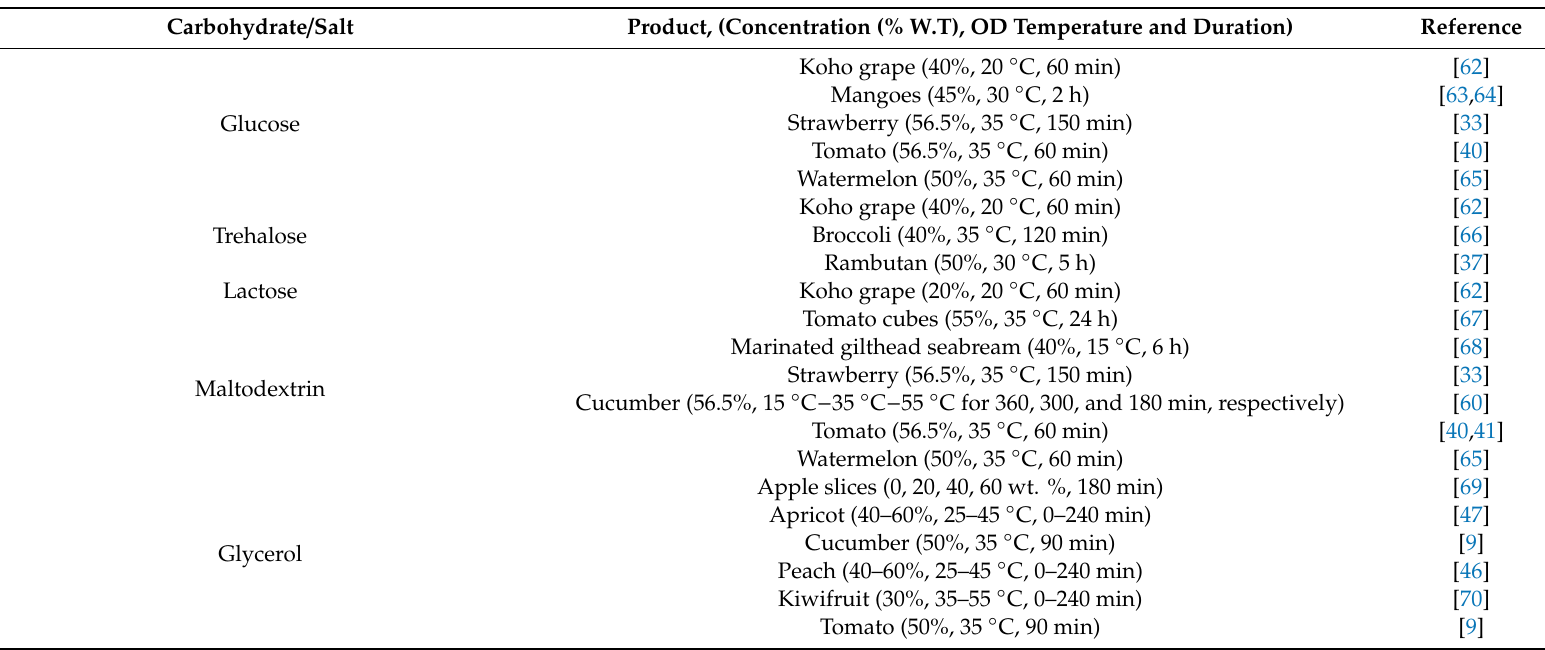
Table 1. Carbohydrates and salts (types and concentrations) used in osmotic solutions in representative studies on osmodehydrofreezing. OD, osmotic